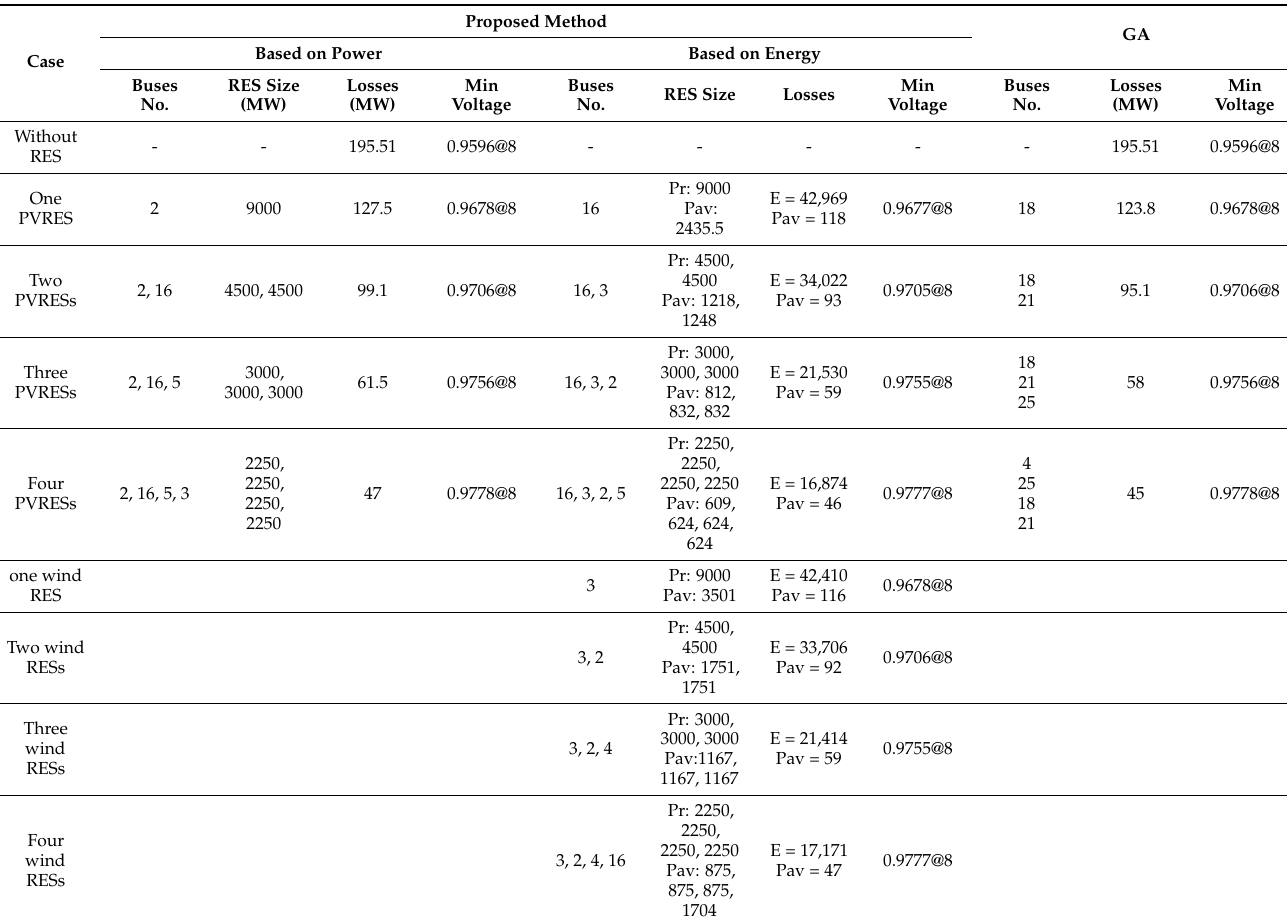
Table 5. PV systems and wind farms buses